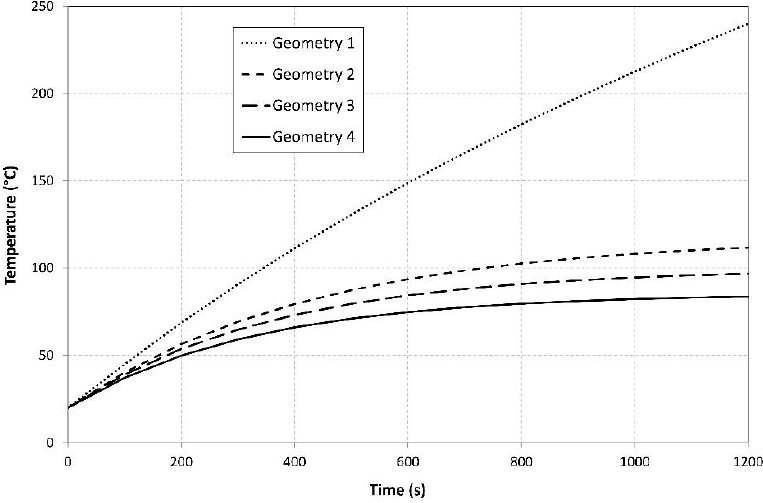
Figure 13. Curves of the mean temperatures of the metal hydride alloy for the individual geometries, as they changed over time.